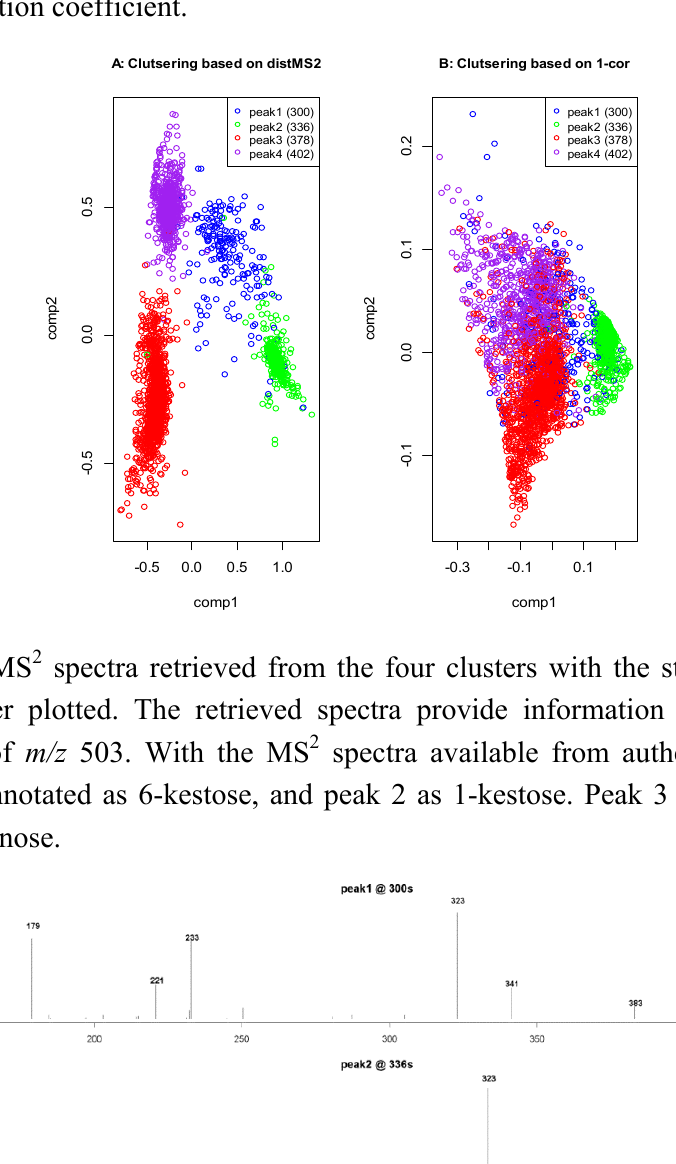
Figure 2. Multidimensional scaling analysis of 3039 tri-hexoside MS 2 spectra based on distMS2 and 1-correlation coef. Retention times of all the MS 2 scans are superimposed to show the correspondence between the fragmentation patterns and LC column behavior. ( A ) Distance metric based on distMS2. ( B ) Distance metric based on 1-r. r refers to Pearson’s correlation coefficient.